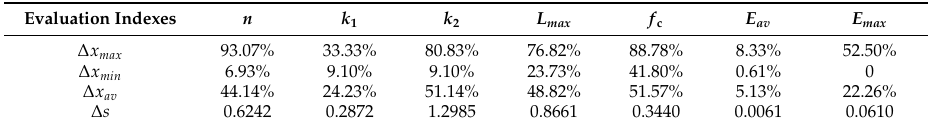
Table 3. Evaluation indexes values of each